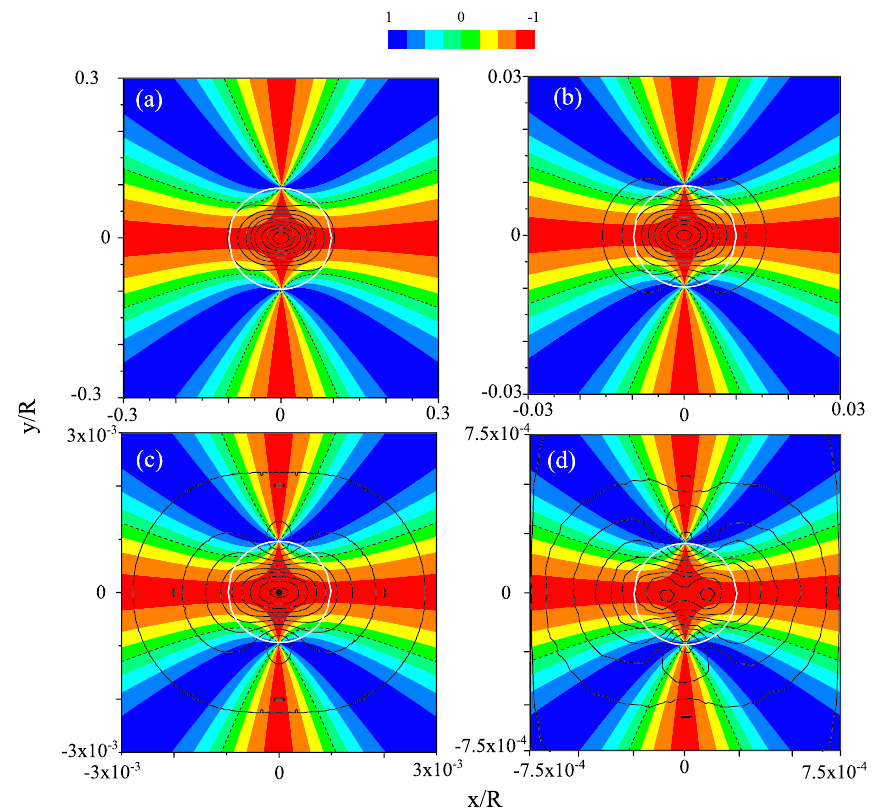
FIG. 4. Stokes parameter S 3 and level lines of radiation intensity in the plane ð x=R; y=R Þ (R being the distance between the source and the observation plane), (a) E e ¼ 5 . 3 MeV, (b) E e ¼ 53 MeV (c) E e ¼ 530 MeV (d) E e ¼ 2000 MeV. Classical treatment. In white, the circle 1 = γ . The dashed curves are the solution of Eq.